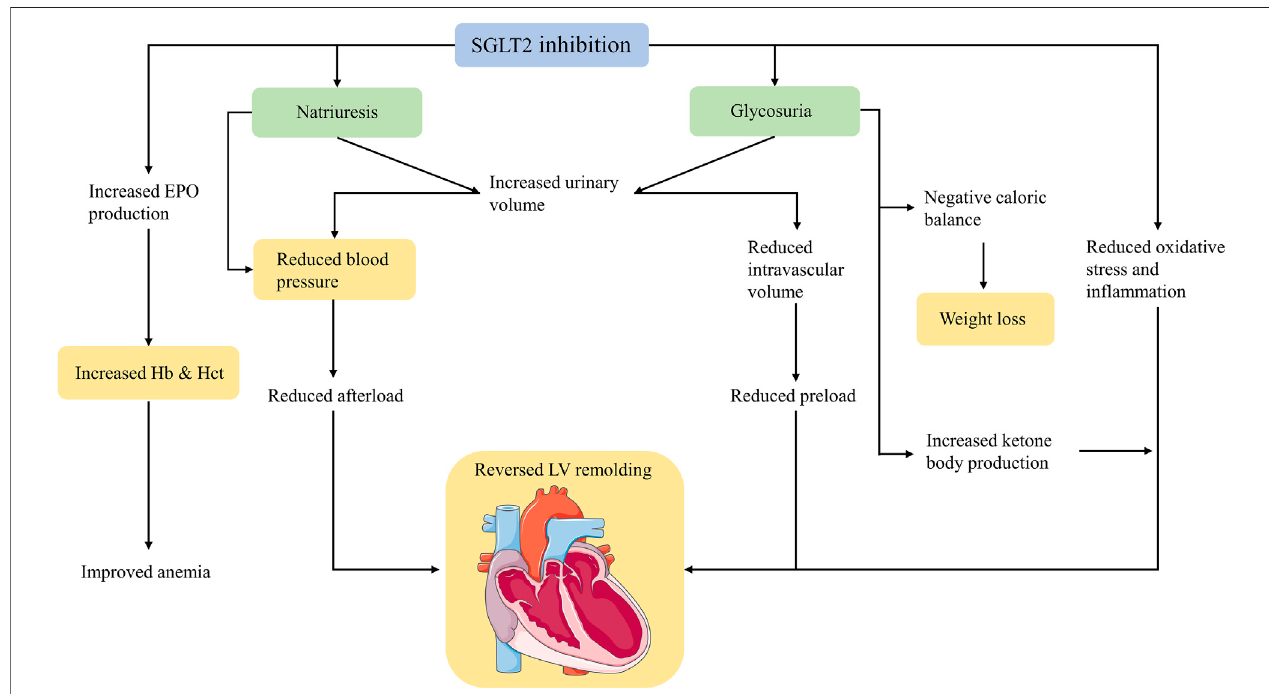
FIGURE 2 | Mechanisms of cardiovascular protection of SGLT2 inhibitors mentioned in this article. SGLT2, sodium-glucose cotransporter 2; EPO, erythropoietin; Hb, haemoglobin; Hct, haematocrit; LV, left ventricular.